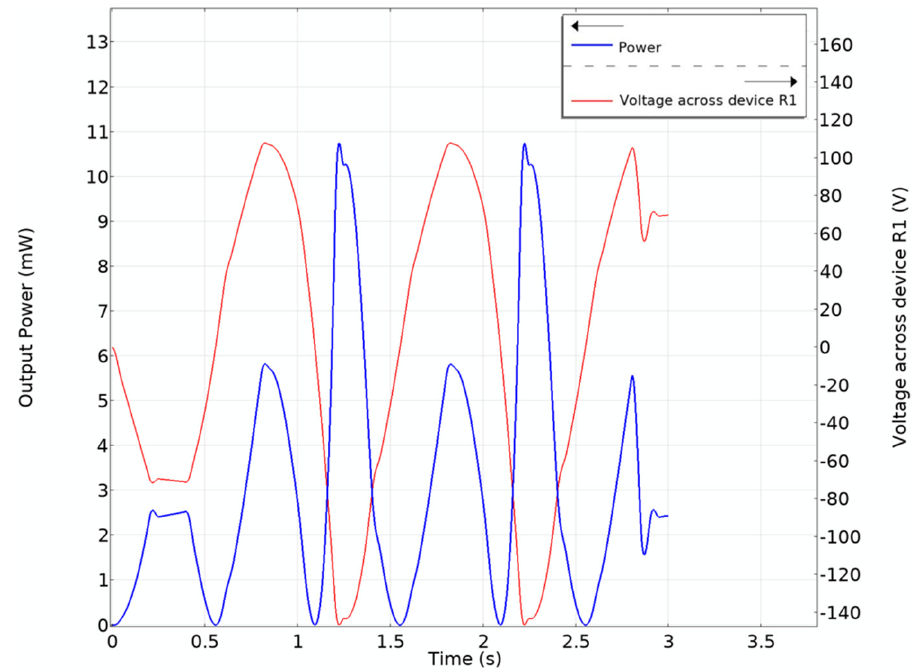
Figure 12. Time-dependent power (mW) and voltage (V) simulation on COMSOL ® . The peak power generated by the piezoelectric sheet is just under 11 mW/step, which closely matches the mathematical